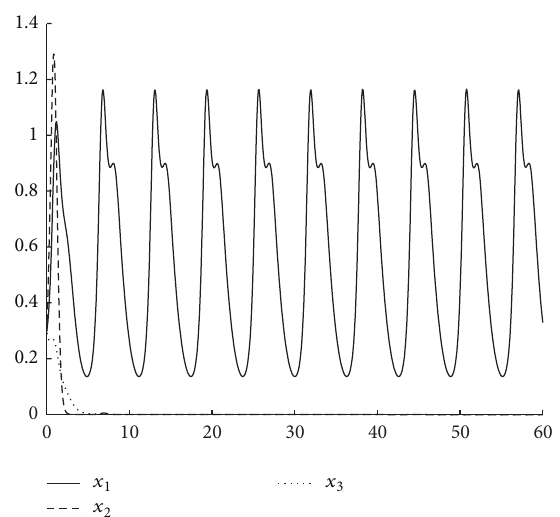
Figure1:Dynamicbehaviorsofsystem(59).Here,wetaketheinitial conditions 𝑥 1 (𝜃) ≡ 𝑥 2 (𝜃) ≡ 𝑥 3 (𝜃) = 0.3 for all 𝜃 ∈ (−∞,0]